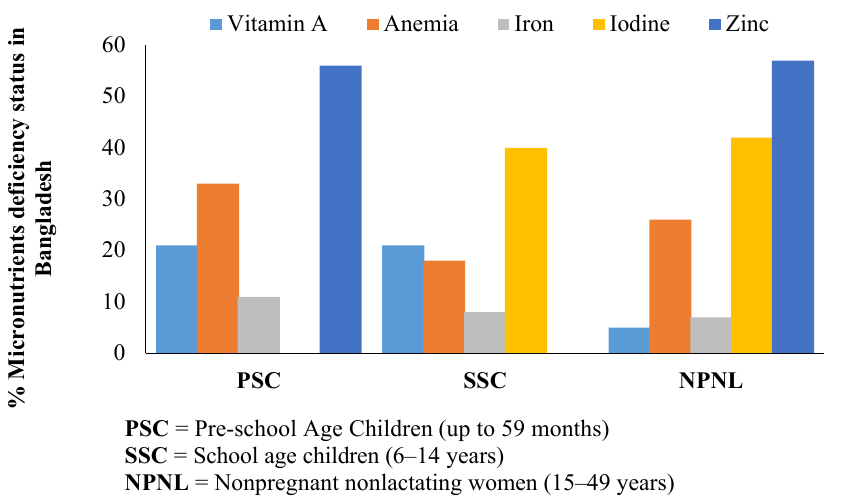
Fig. 2 Micronutrient deficiency in Bangladesh (percent of the surveyed population). Source: